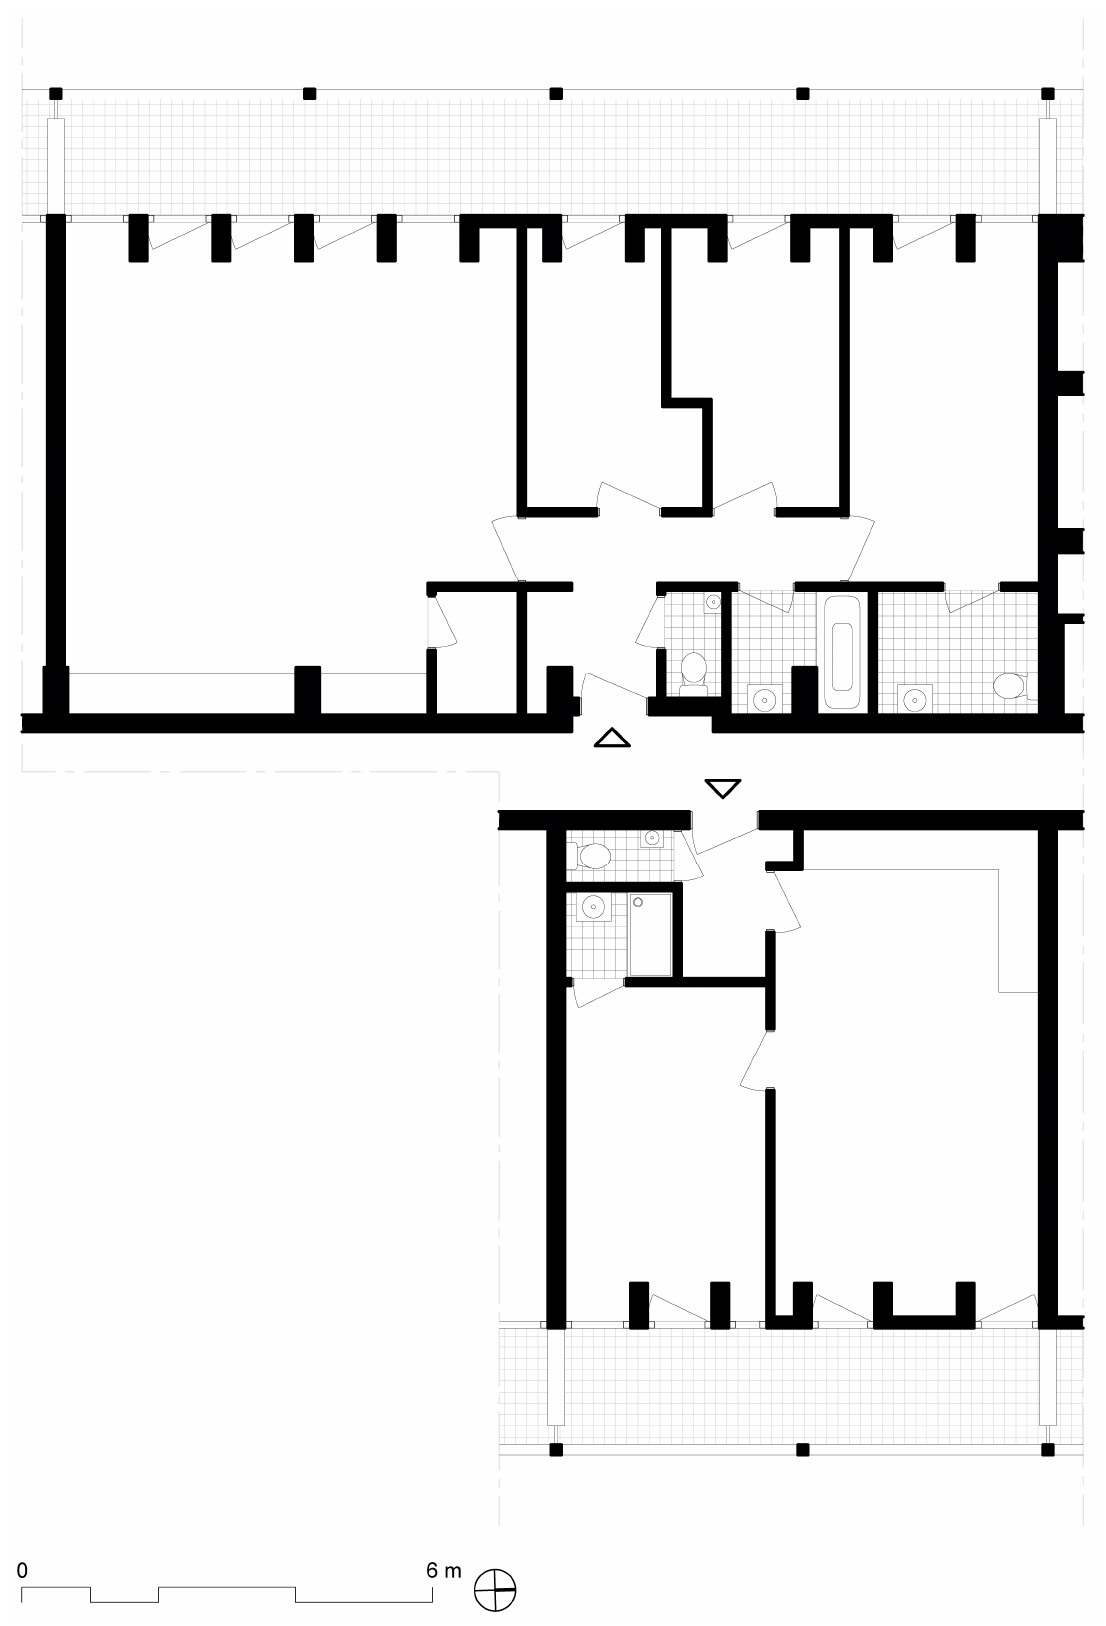
Figure 14. Dwelling plan of the project “Cosmopolitan” by Bogdan and Van Broeck architects (re-drawing by the authors).